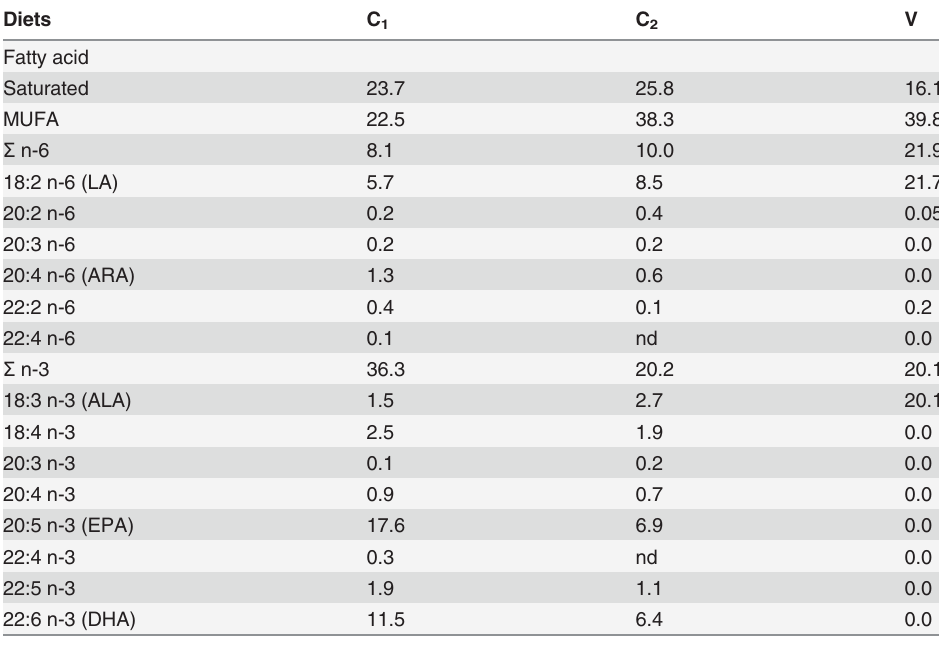
Table 2. Fatty acid composition (% of total fatty acids) of diets. Diets C 1 C 2 V Fatty acid Saturated